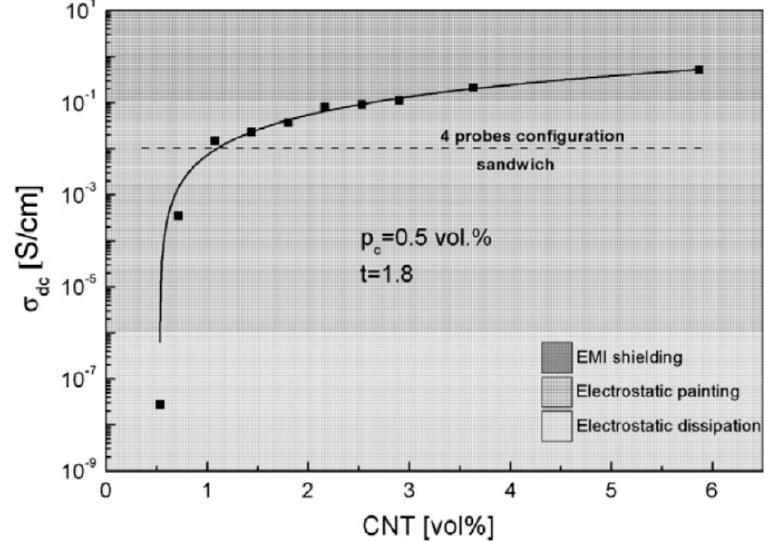
Figure 7. DC conductivity vs. MWCNT vol% for nanocomposites with regard to the percolation threshold [3].